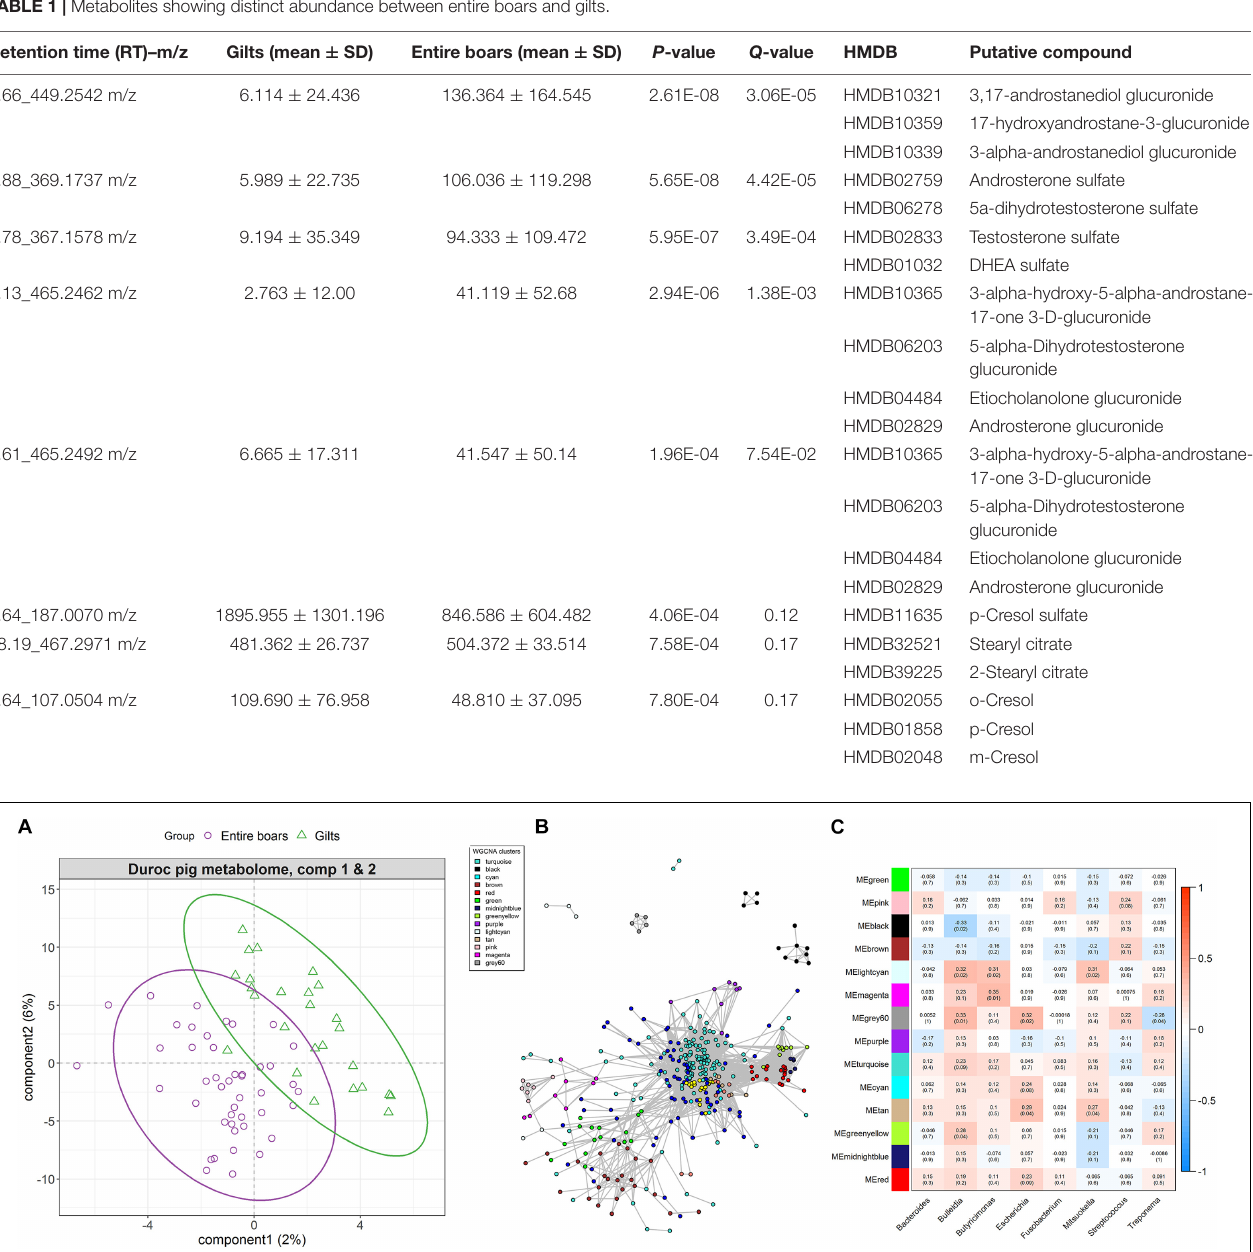
FIGURE 4 | The differentiation of host serum metabolite profile between entire boars and gilts, and its associations with sex-biased bacteria in the Duroc pig cohort. (A) sPLS-DA plot of serum metabolite profiles, which indicates the significant differentiation of serum metabolite profiles between entire boars and gilts. (B) Co-occurrence network of serum metabolite features. The metabolites (nodes) are colored according to WGCNA module colors. Only those correlations with | r | > 0.2 between two edges were presented. (C) Correlations between metabolite modules and sex-biased bacteria. Each box of the matrix represents the correlation between one metabolite module and a sex-biased bacterial taxon at the genus level. The correlation coefficient (r) and the corresponding P -value (in brackets) were filled in the small boxes. The color gradient represents the values of correlation coefficients (red for positive correlations and blue for negative